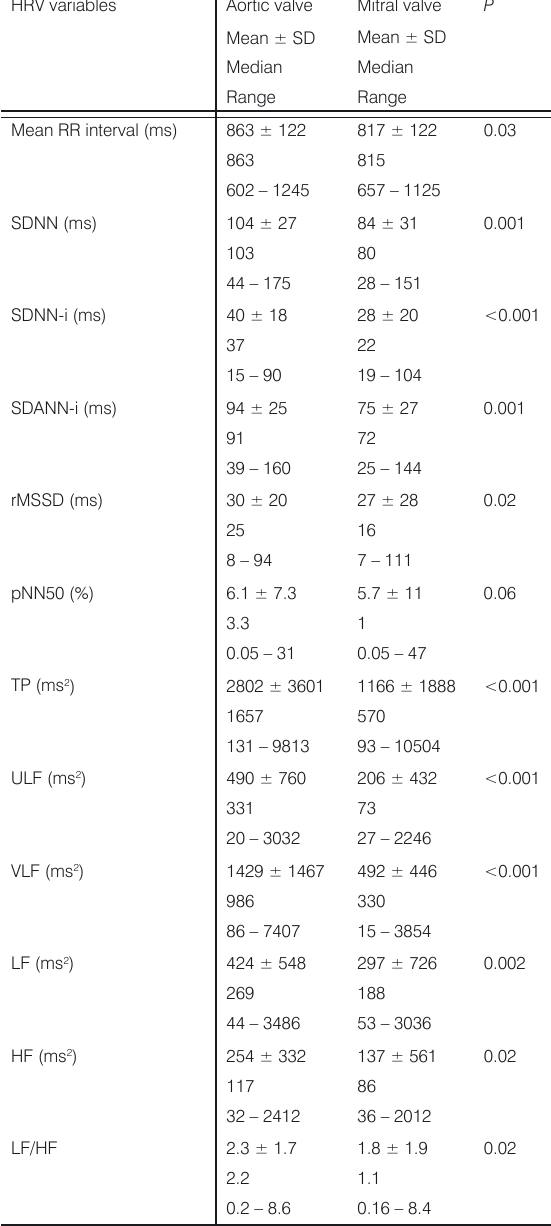
Table 3. Differences in HRV between patients with an implanted artificial aortic vs. mitral